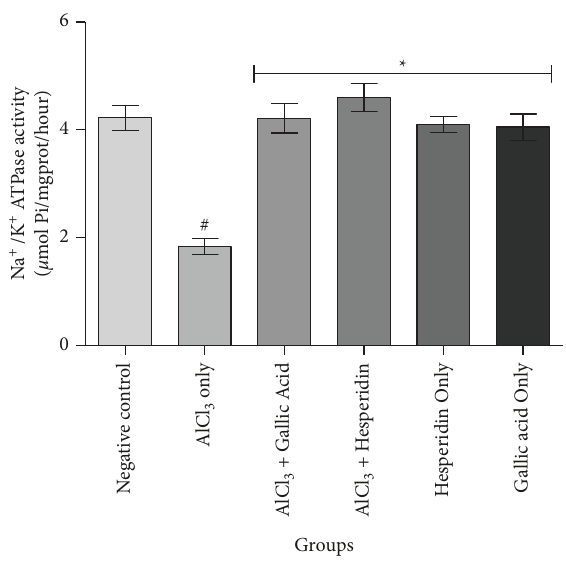
Figure 1: Effect of gallic acid and hesperidin on renal Na + /K + ATPase activity in AlCl 3 -induced nephrotoxicity in Wistar rats. Values are expressed as the mean ± standard deviation of six de- terminations. # p < 0 . 05 vs negative control, ∗ p < 0 . 05 vs. AlCl 3 only.